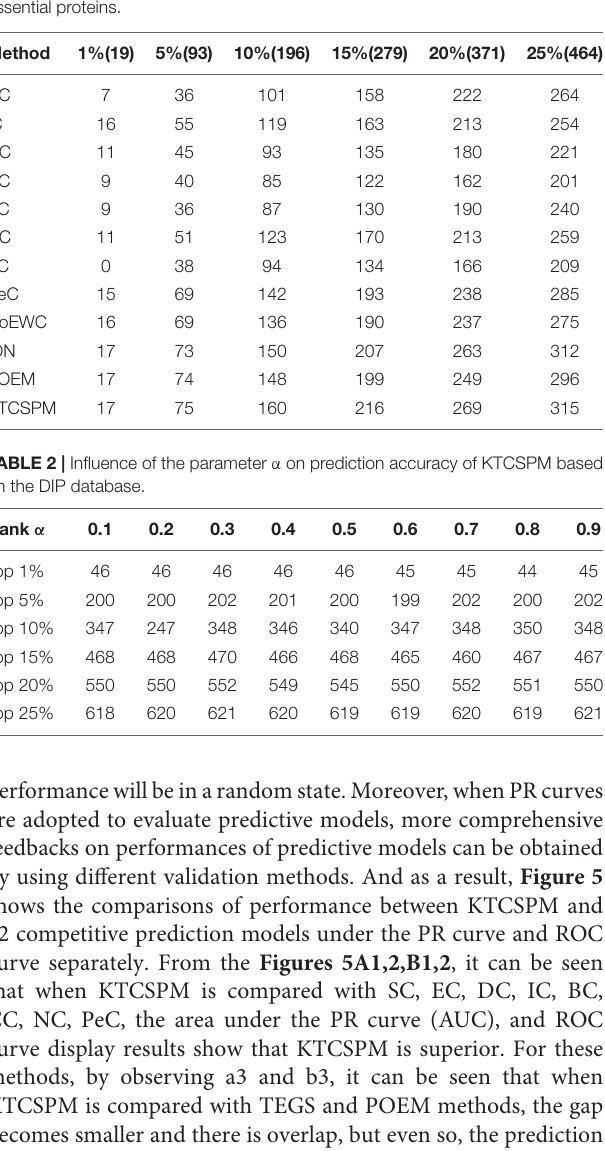
TABLE 1 | Comparison results between KTCSPM and 11 state-of-the-art methods including DC, IC, CC, BC, NC, EC, PeC, CoEWC, ION, and POEM based on the Gavin database, where the Gavin database consists of 1,855 essential proteins.